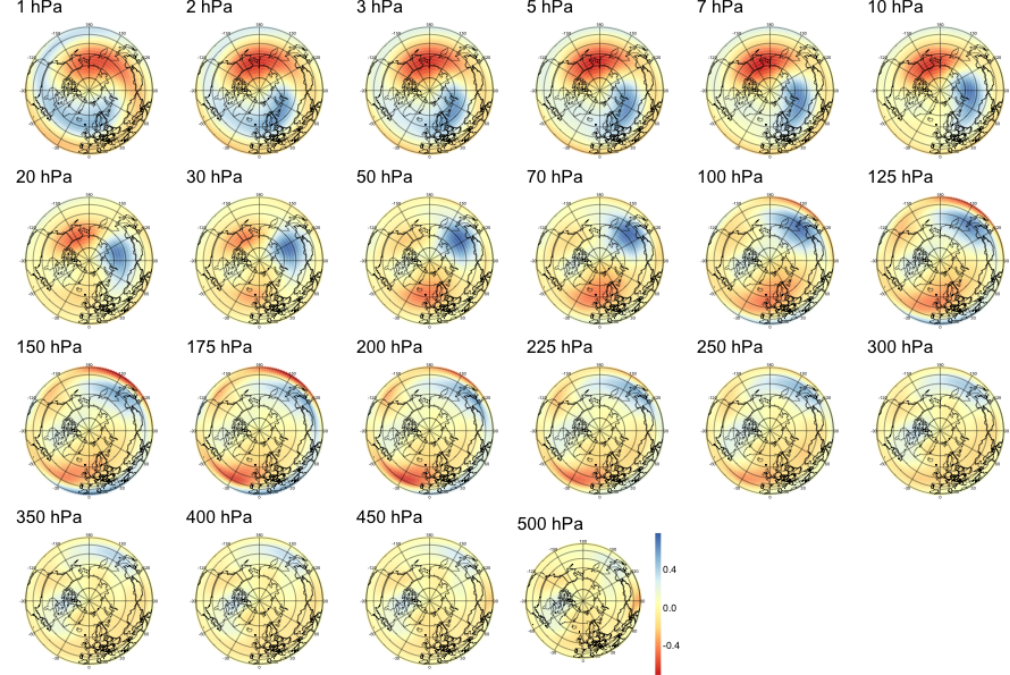
Figure B9. Pattern of PV waves maximizing correlation with the SSW index at a lead time of 44d.